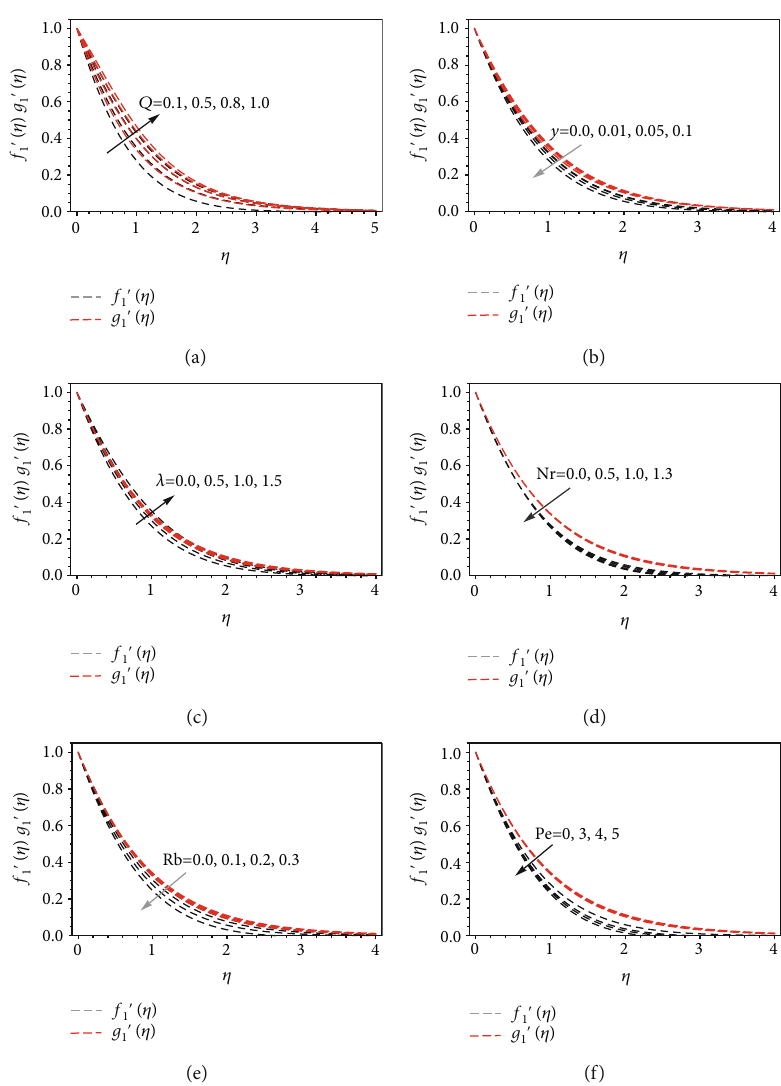
Figure 3: Velocity pro fi le on x and y directions for various values of Q , γ , λ , Nr, Rb , and Pe